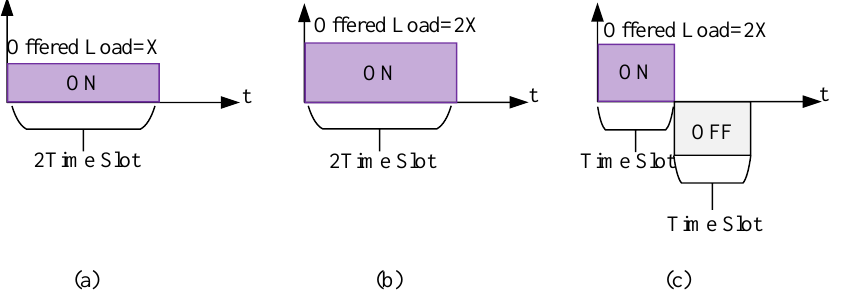
Figure 6. Sleep/Wake-up mode schematic. ( a ) Transmission before applying the sleep/wake-up technique, ( b ) offered load multiplication by factor X, ( c ) wake-up and sleep duration division by same factor